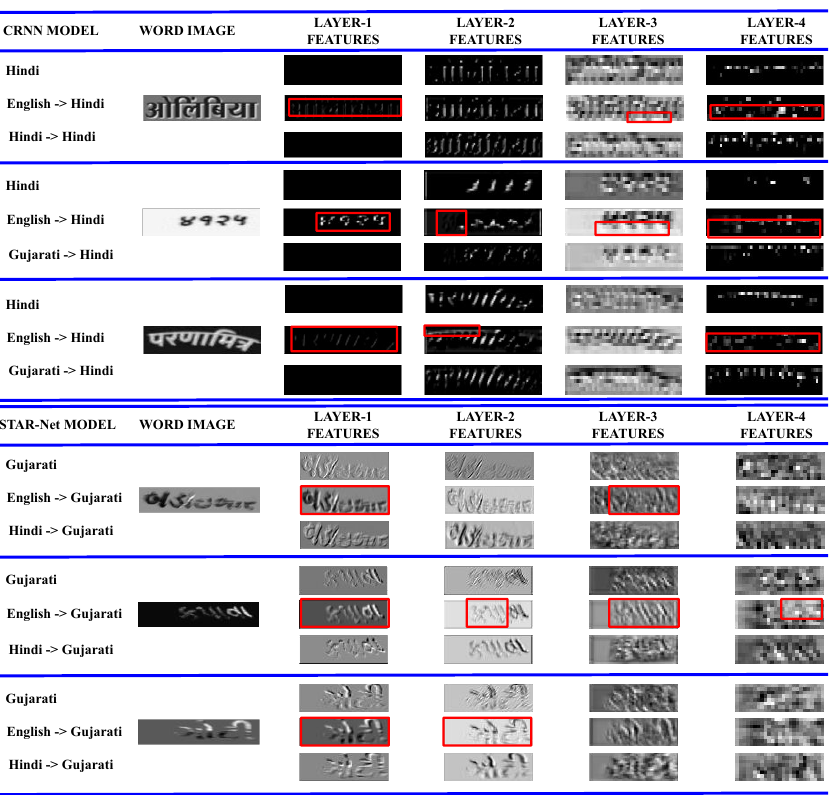
Figure 7. CNN layers visualization in the ( Top ): Baseline 1 (CRNN) models trained on Hindi, English Hindi, and Gujarati Hindi; and ( Bottom ): Baseline 2 (STAR-Net) models trained on → → Gujarati, English Gujarati, and Hindi Gujarati. Red boxes indicate the regions where the features → → for the model transferred from English are activated (as white), whereas the features from the other two models are